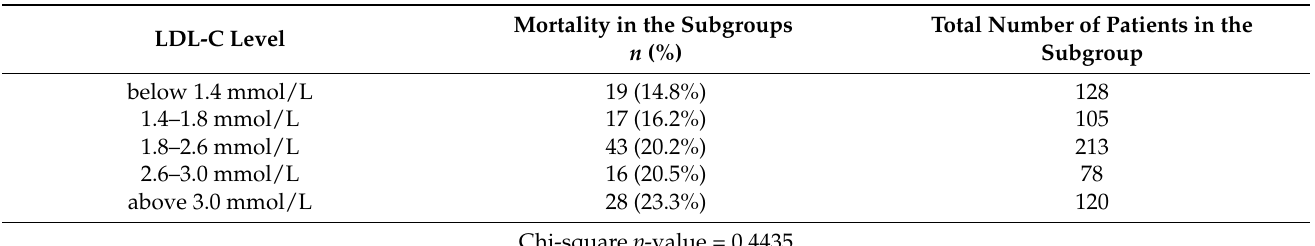
Table 3. Nine-year mortality in subgroups divided according to ECS cardiovascular LDL-C threshold. LDL-C